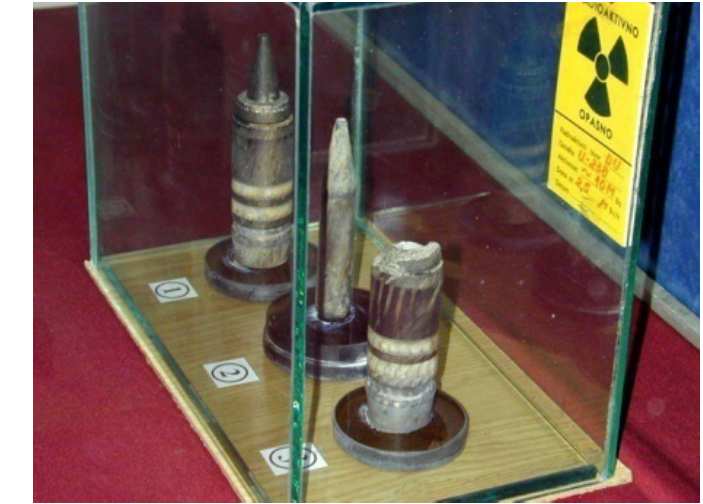
Figure 4 – DU rounds used in the territories of the FR of Yugoslavia in 1999, exhibited at the Military Museum in